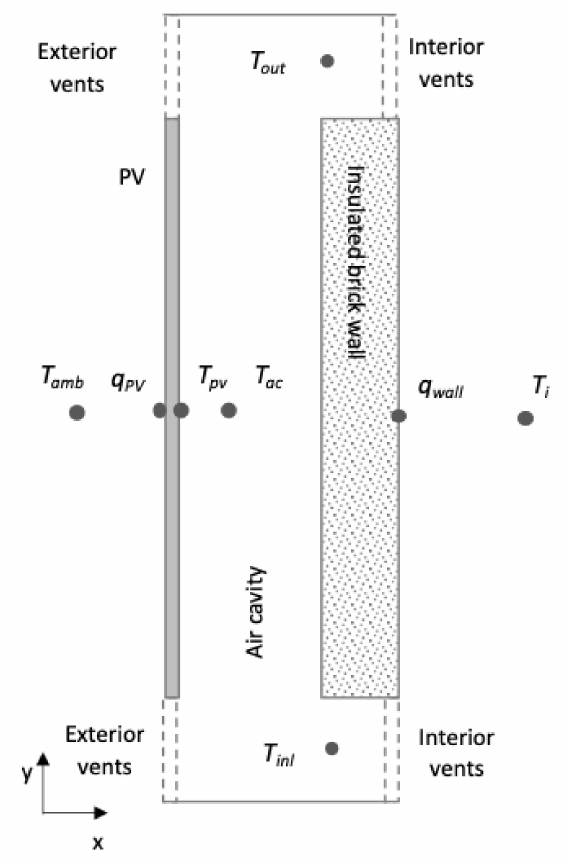
Figure 3. Experimentally measured variables of the